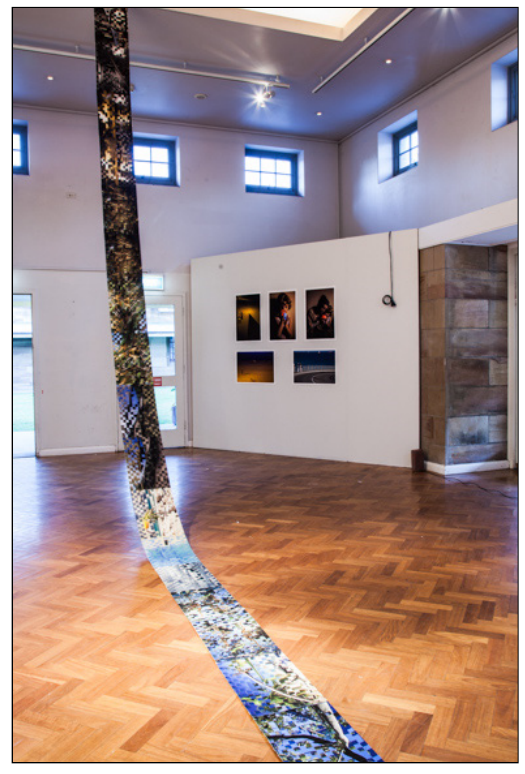
Figure 6. The Keeling (Over) Curve (years dot ‐ thru ‐ dash) in Facing Futures Free From Fear (2013).